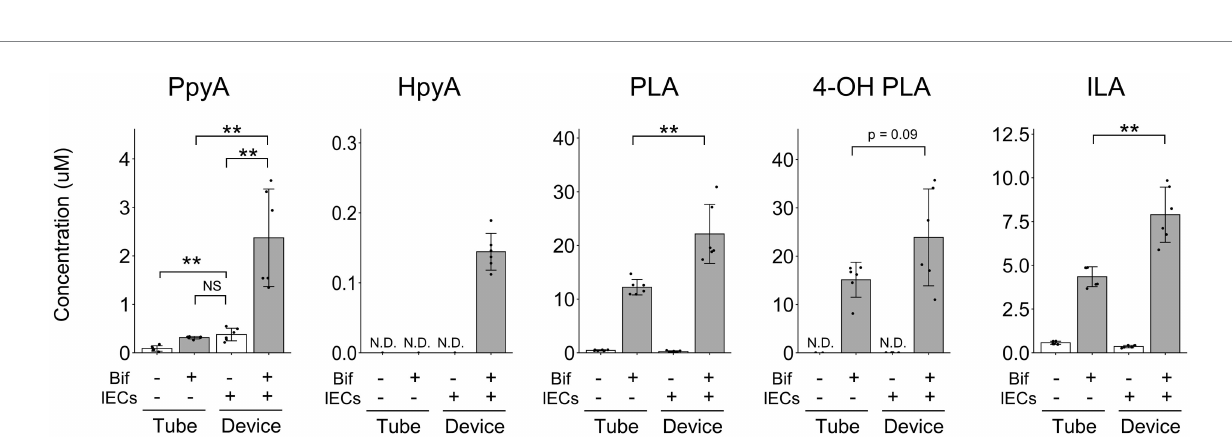
FIGURE 3 Quantitative analysis of aromatic lactic acids and their precursor metabolites. The concentrations of aromatic lactic acid-related metabolites. The data represent the average of six samples from each group, from two independent experiments. * p < 0.05, ** p < 0.01 (Welch’s t -test) N.D., not